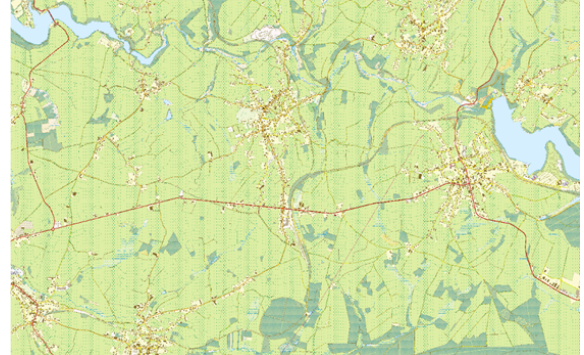
Figure 2. Original map stimulus shown in memory task (This map stimulus is the same material used by Ooms (2012). This data was produced by Belgian national mapping agency, NGI/IGN (Nationaal Geografisch Instituut/Institut Géographique